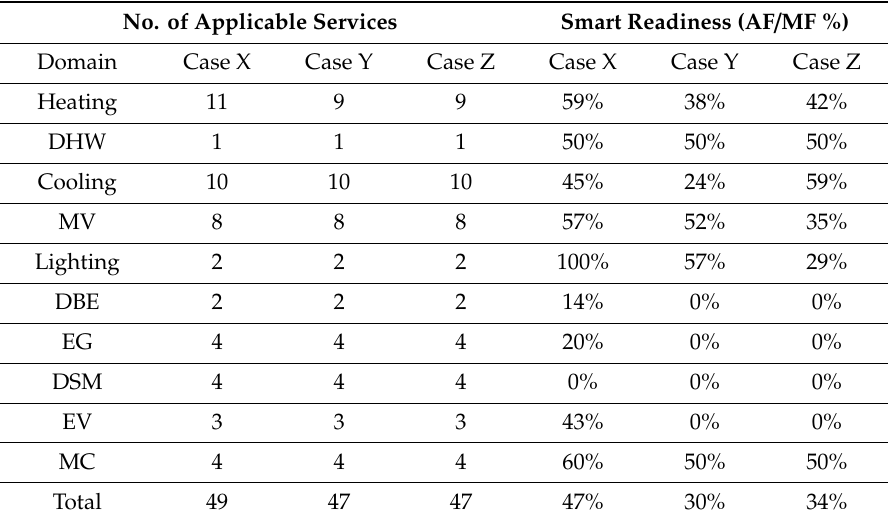
Table 15. The resulting level of smart readiness after triage process